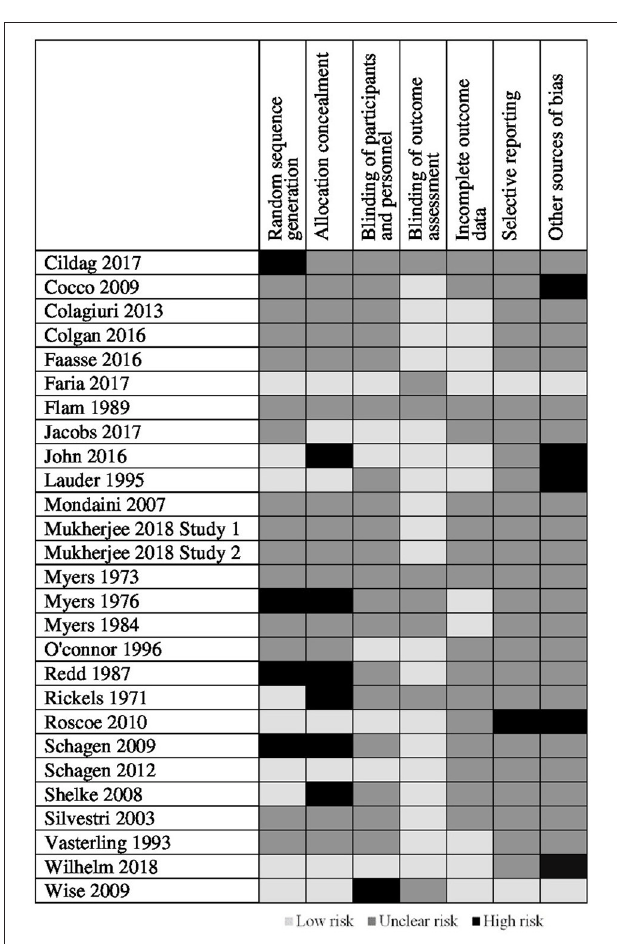
FIGURE 3 | Quality assessment between included studies.